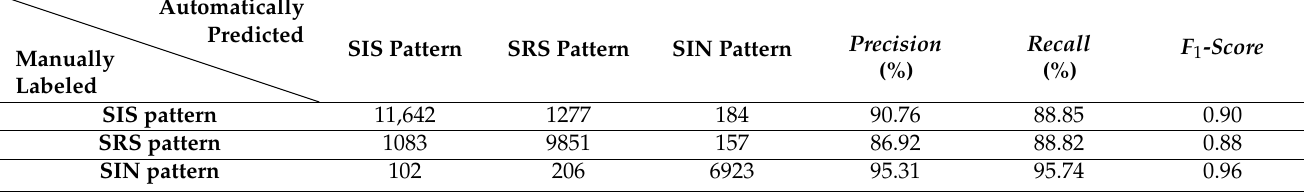
Table 2. Confusion matrix and three evaluation metrics for lixel classification of the test samples using 1D-U-Net.